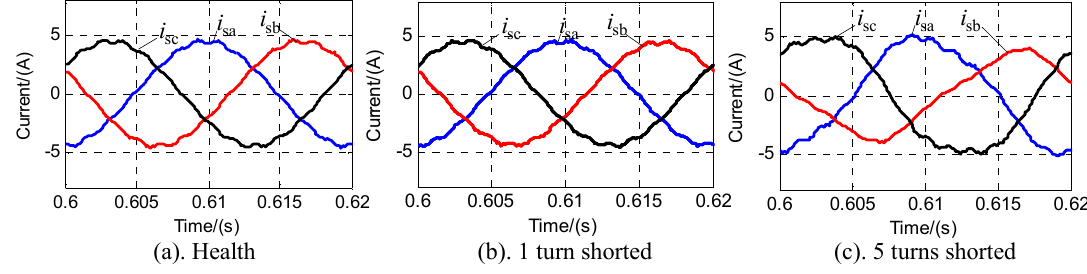
Figure 12. Currents of stator phases for R f = 0.1 Ω with different shorted turns.